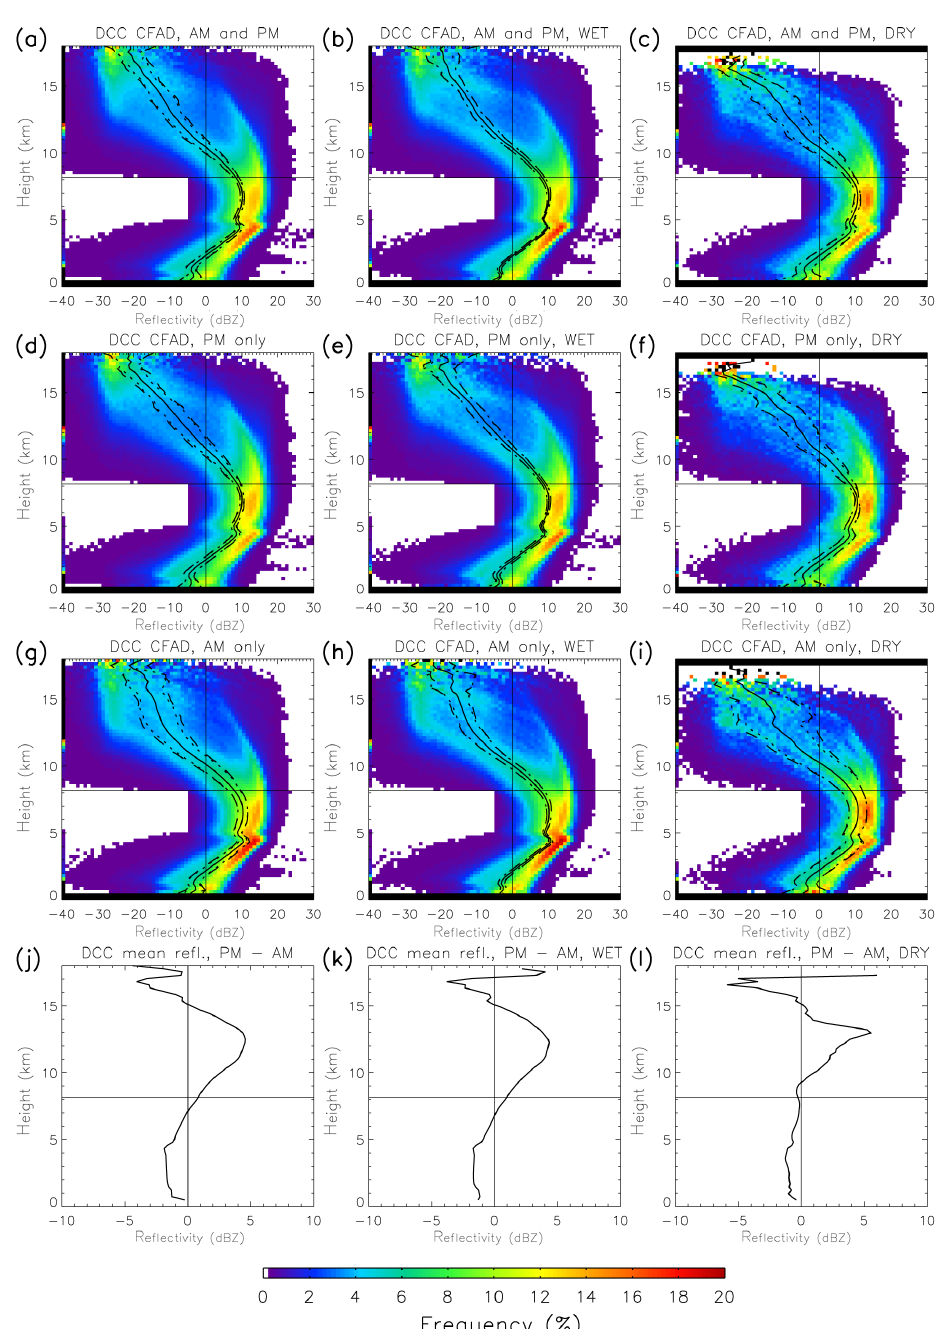
Figure 5. (a–i) The CFADs of reflectivity for DCCs in Amazonia separated by time of day and season. The left column is for all four seasons (wet, dry, wet-to-dry, and dry-to-wet); the middle column is for the wet season (WET); and the right column is the dry season (DRY). The first row is results for both times of day, the second row is day-only, and the third row is night-only. (j–l) The difference between the day and night mean reflectivity profile values – i.e, the second row minus the third